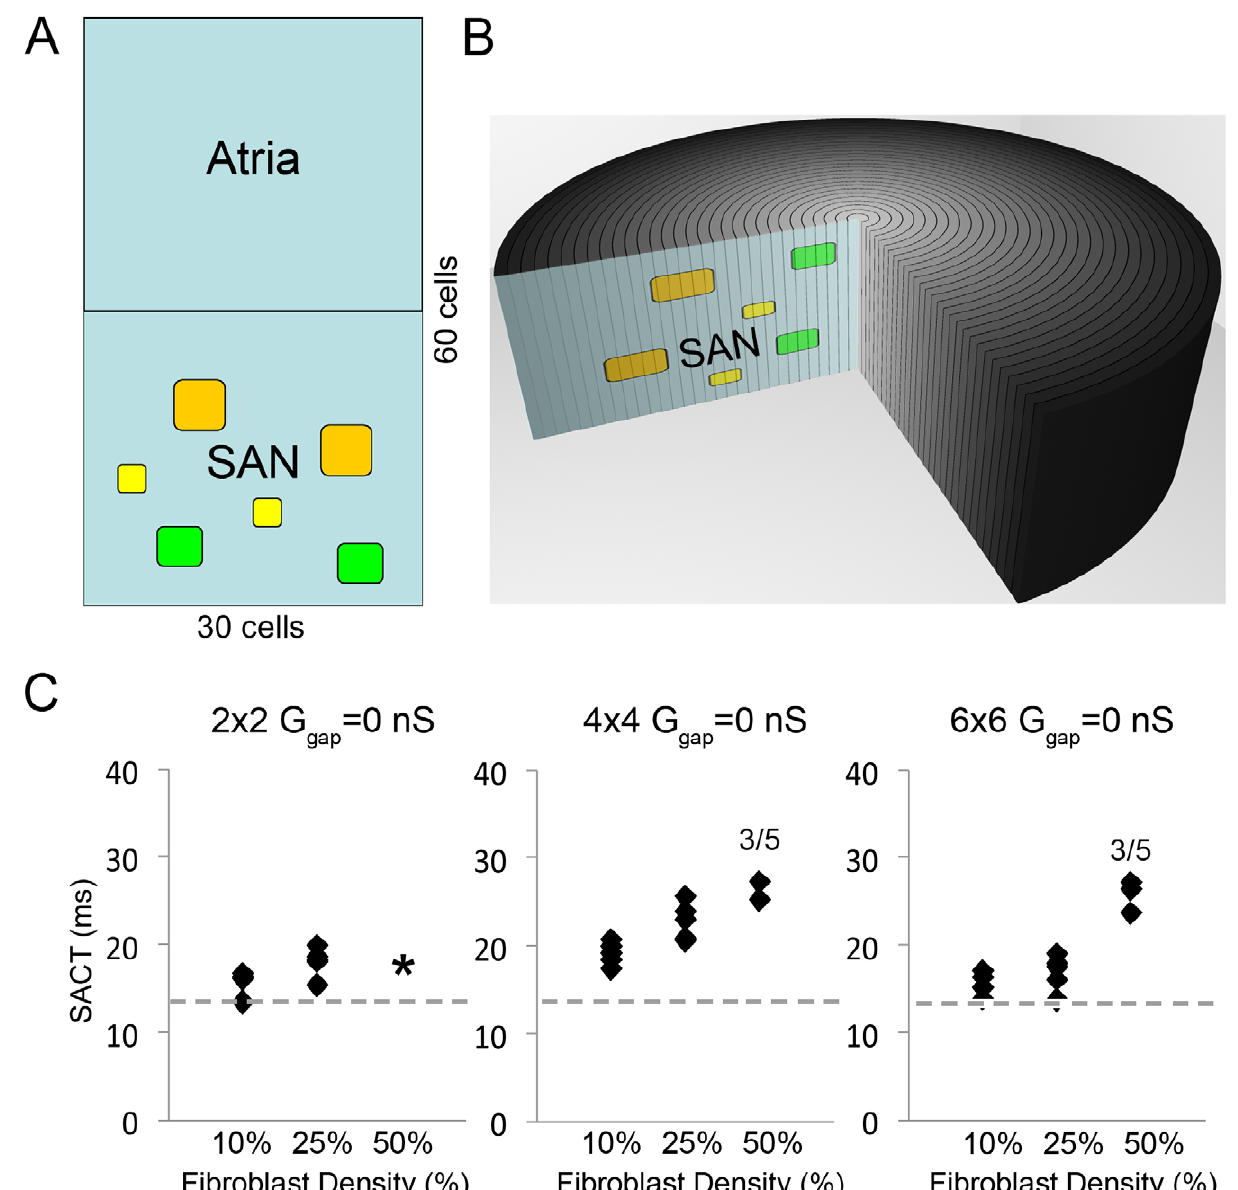
Figure 4. The effect of fibroblasts in the SAN. A and B: Schematic of a 3D tissue and 2D slice incorporating different sized islands of fibroblasts: 2 6 2 (yellow), 4 6 4 (green) and 6 6 6 (orange) within the SAN region. Panel C: Uncoupled fibroblasts and myocytes act as obstacles to electrical impulse propagation. For fibroblast-myocyte coupling of 0nS (G gap =0 nS), as fibroblasts percentage coverage increases sinoatrial node to atrium conduction time (SACT) increases for all islands sizes (left - 2 6 2, middle - 4 6 4, right - 6 6 6) and distributions (see Figure 3 in Text S1 for all distribution maps). Each fibroblast density (10%, 25% or 50%) is represented by 5 distributions (black diamonds). The dashed gray line denotes the SACT control value (13.8 ms).